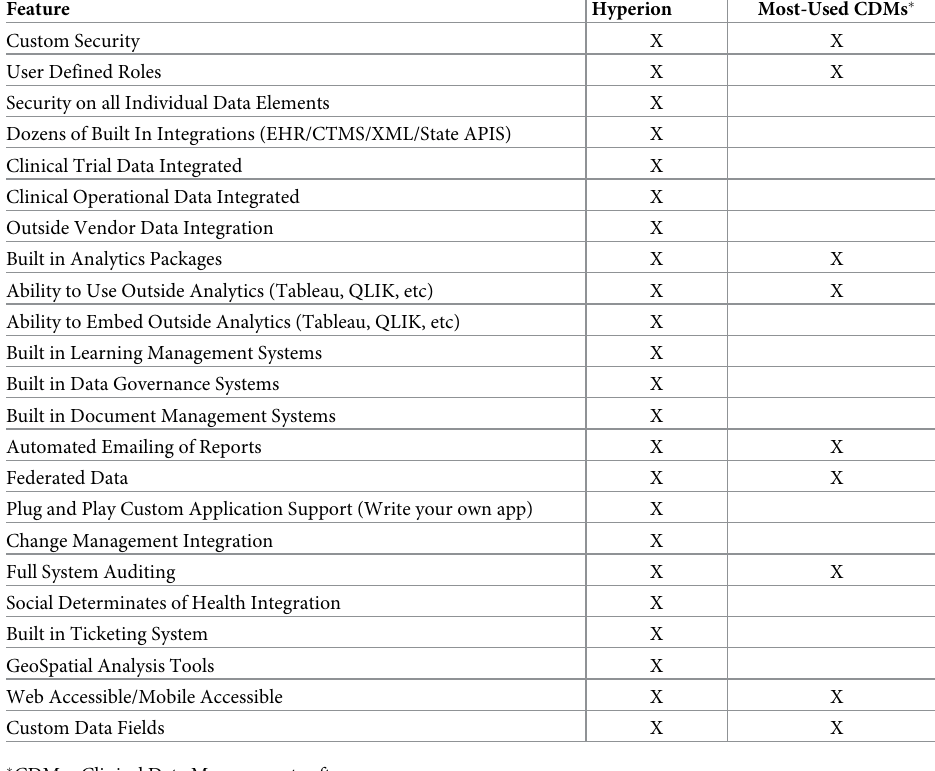
Table 1. Comparison of features: Hyperion versus other commercially available, commonly used clinical data management software systems.